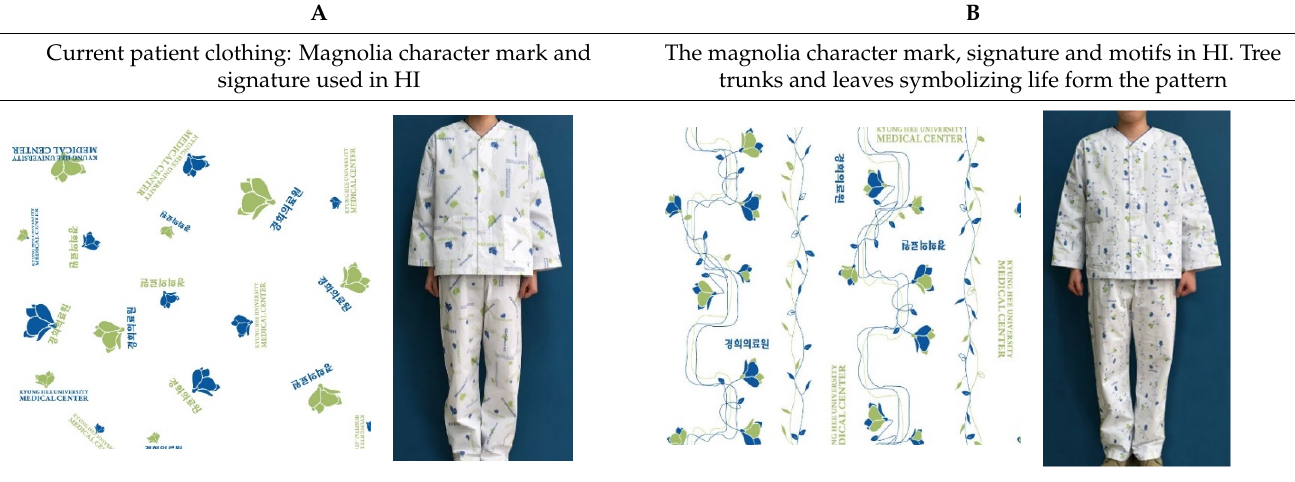
Table 2. Nature experience healing characteristics: the patient clothing design stimulus. A Current patient clothing: Magnolia character mark and